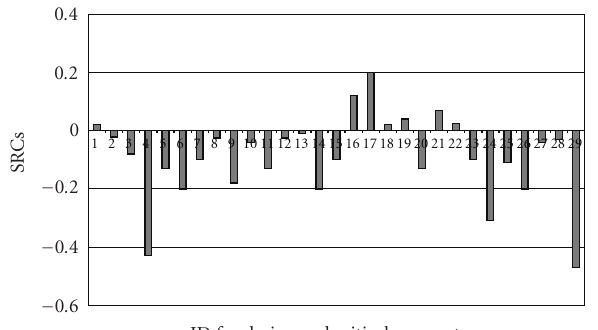
Figure 26: Standardized regression coe ffi cients for the defined performance indicator: W/W